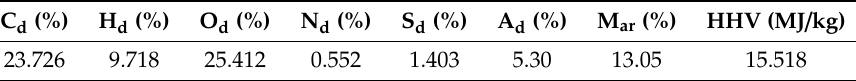
Table 2. Waste liquor elemental analysis and heat value.